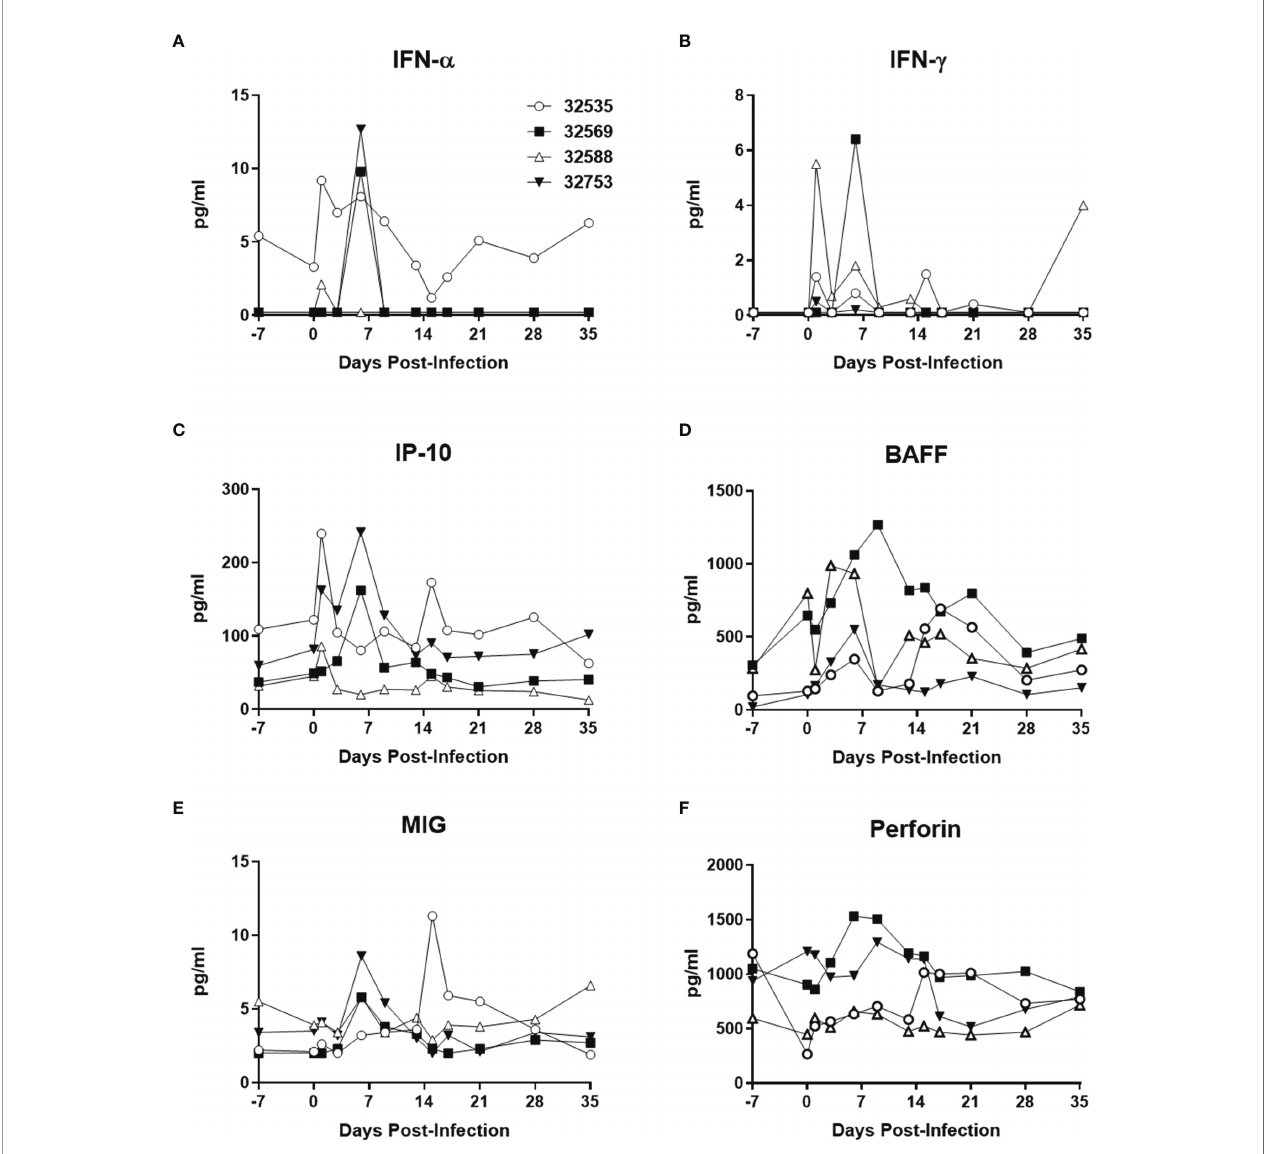
FIGURE 3 | Baboon plasma cytokine levels after ZIKV PR infection. (A) IFN- a , (B) IFN- g , (C) IP-10/CXCL10, (D) BAFF, (E) MIG/CXCL9, and (F) perforin. Cytokines were measured using Luminex assays. The baboons were challenged with the virus in either a high dose of 10 6 TCID 50 ( n = 2, open symbols) or a low dose of 10 4 TCID 50 ( n = 2, closed